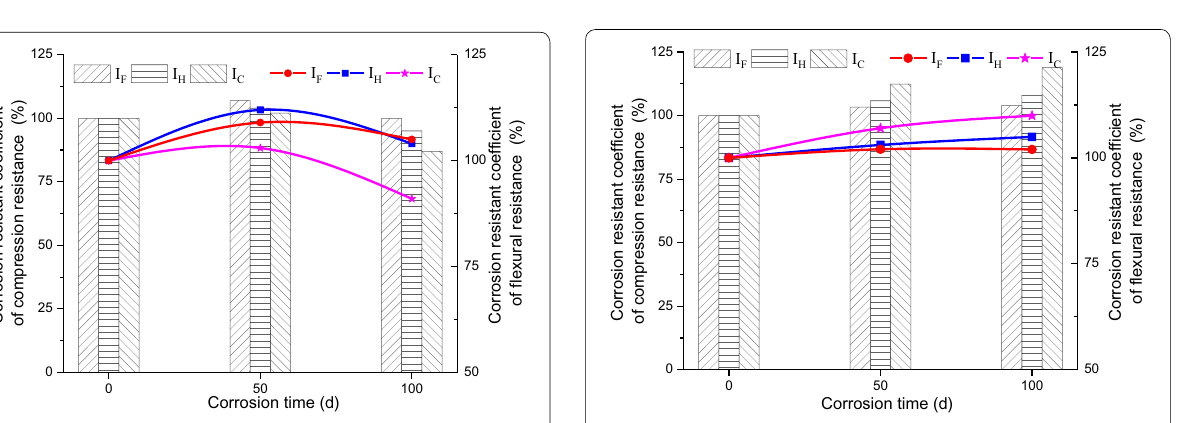
Fig. 7 Effect on strength of C50 concrete caused by three corrosion